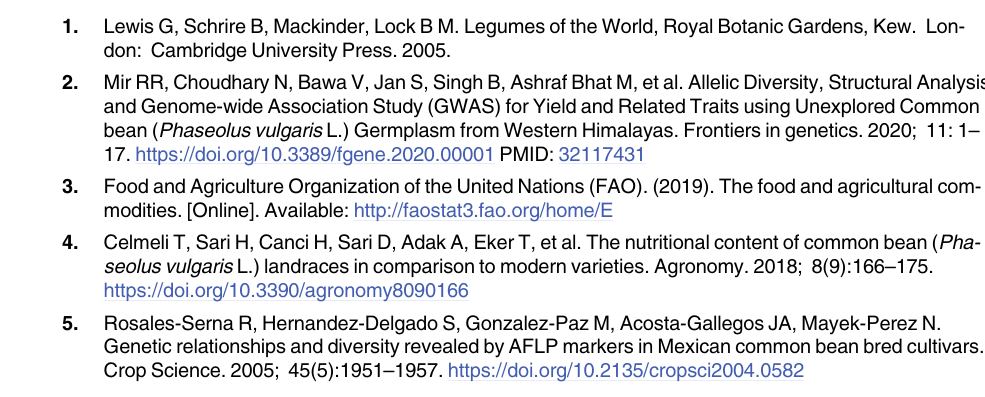
S3 Table. Mean and Standard error of morphological trait values. Means are averages across 2017 and 2018 for 34 Phaseolus vulgaris accessions. S4 Table. Statistics for morphological traits by genetic cluster for 34 Phaseolus vulgaris accessions. A. Statistics for Blue cluster. B. Statistics for Red cluster. S5 Table. Trait values for accession DUD-11 compared to ranges of values for Red (Meso- american) and Blue (Andean) clusters. Low: lowest value of trait among accessions within cluster. High: Highest value of trait among accession within